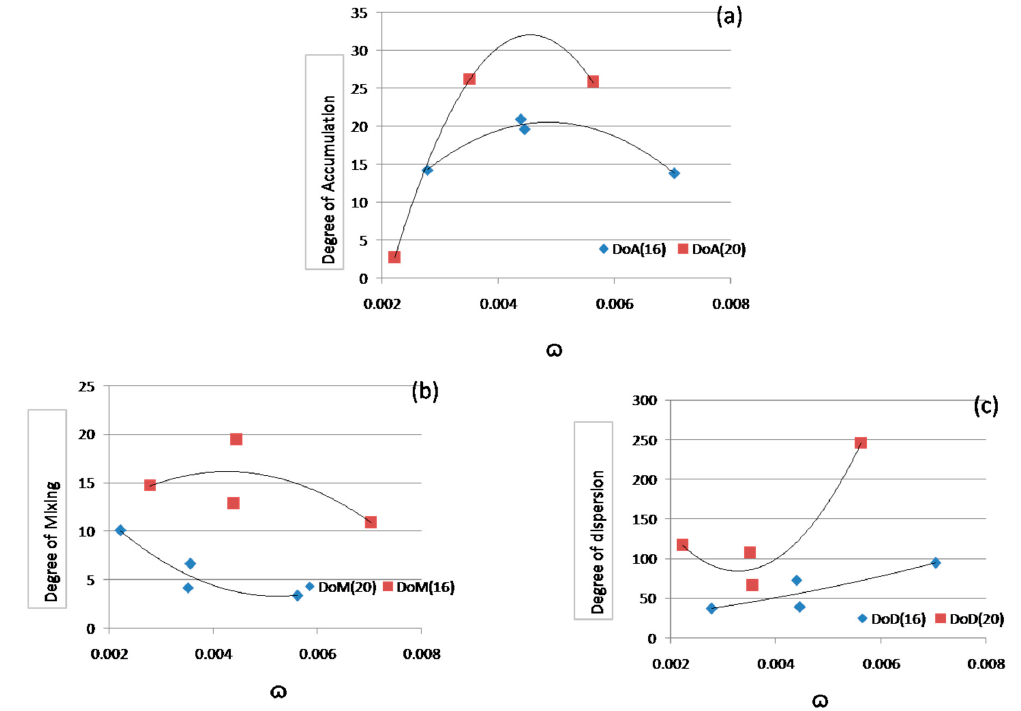
ϖ ”on ( a ) D a , ( b ) D m , and ( c ) D d. Figure 6. Effect of “ (cid:118) ” on ( a ) D a , ( b ) D m , and ( c ) D